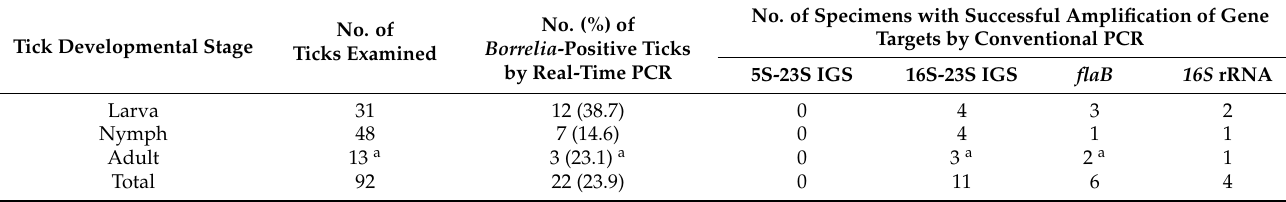
Table 2. Number and prevalence of Borrelia bacteria detected in different stages of Carios vespertilionis . No. of Specimens with Successful Amplification of Gene No. (%) of No. of Targets by Conventional PCR Tick Developmental Stage Borrelia -Positive Ticks Ticks Examined by Real-Time PCR 5S-23S IGS 16S-23S IGS flaB 16S rRNA Larva 31 12